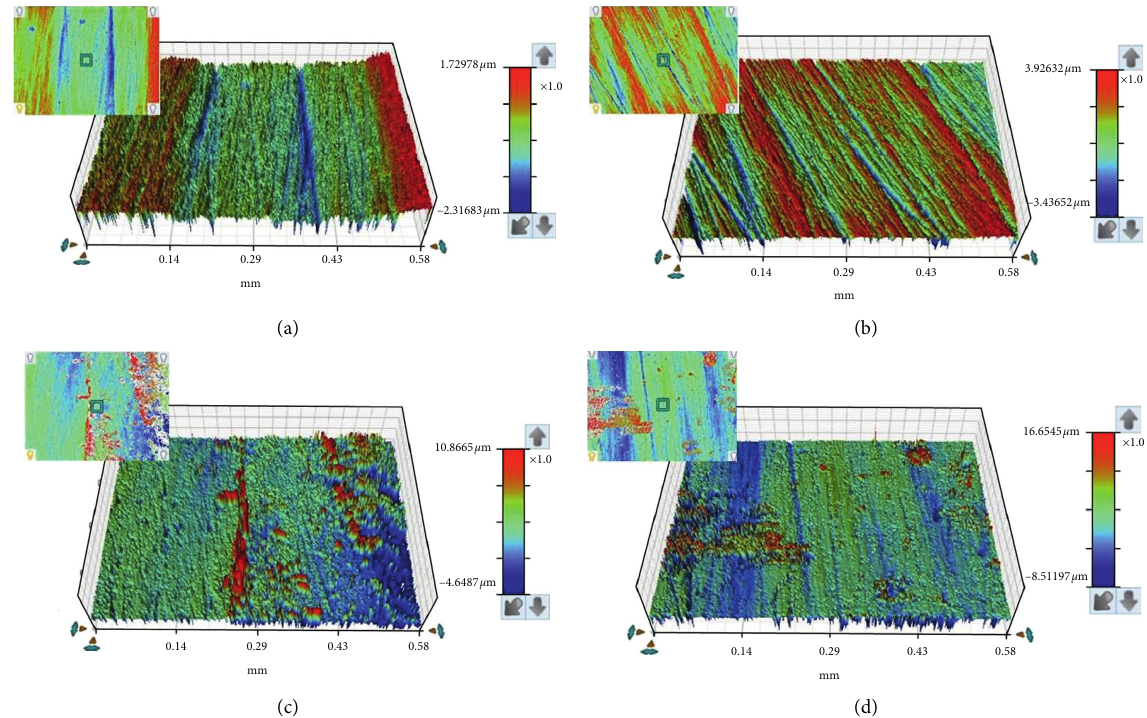
Figure 3: Representative surface roughness images of tested specimens based on different ZrO acrylic resin. (a) Control; (b) 1% ZrO 2 NPs; (c) 2.5% ZrO 2 NPs; (d) 5% ZrO 2 NPs.